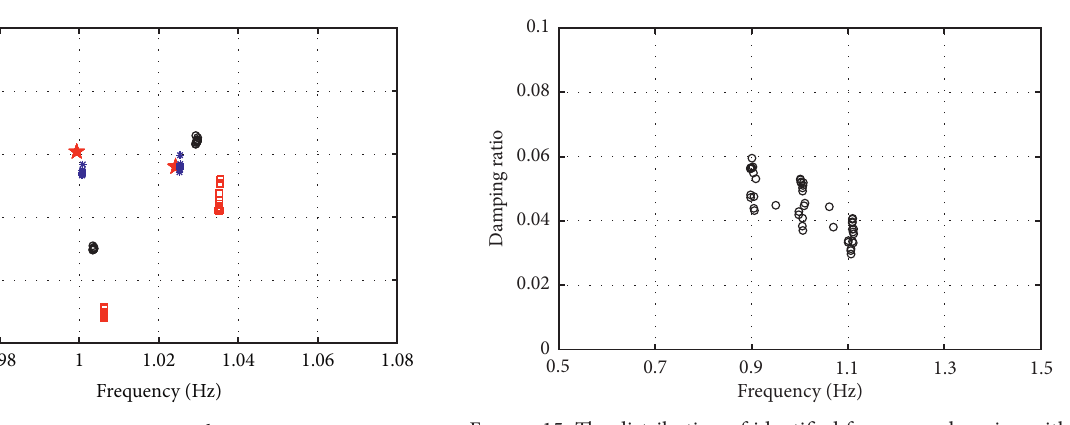
Figure 15: The distribution of identified frequency-damping with model order from 4 to 22, when using 􏽥 h ( k ) by IFFT of S ( ω ) .